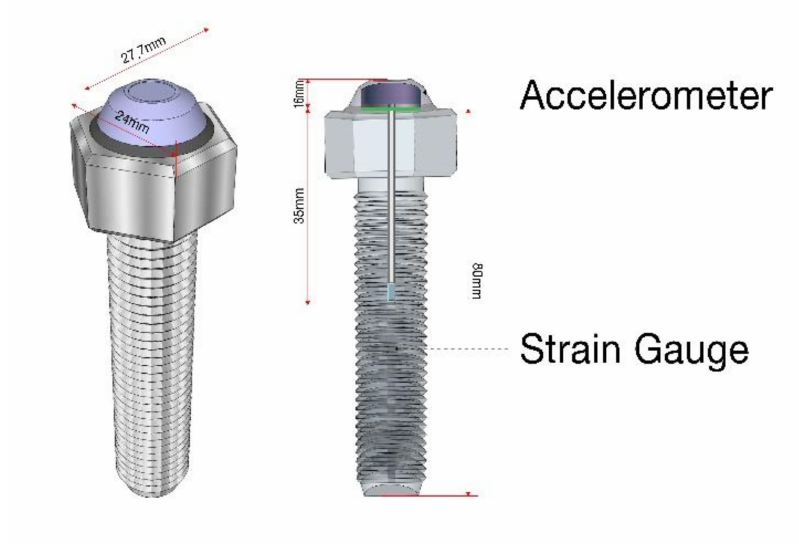
Figure 2. M16 80-mm smart